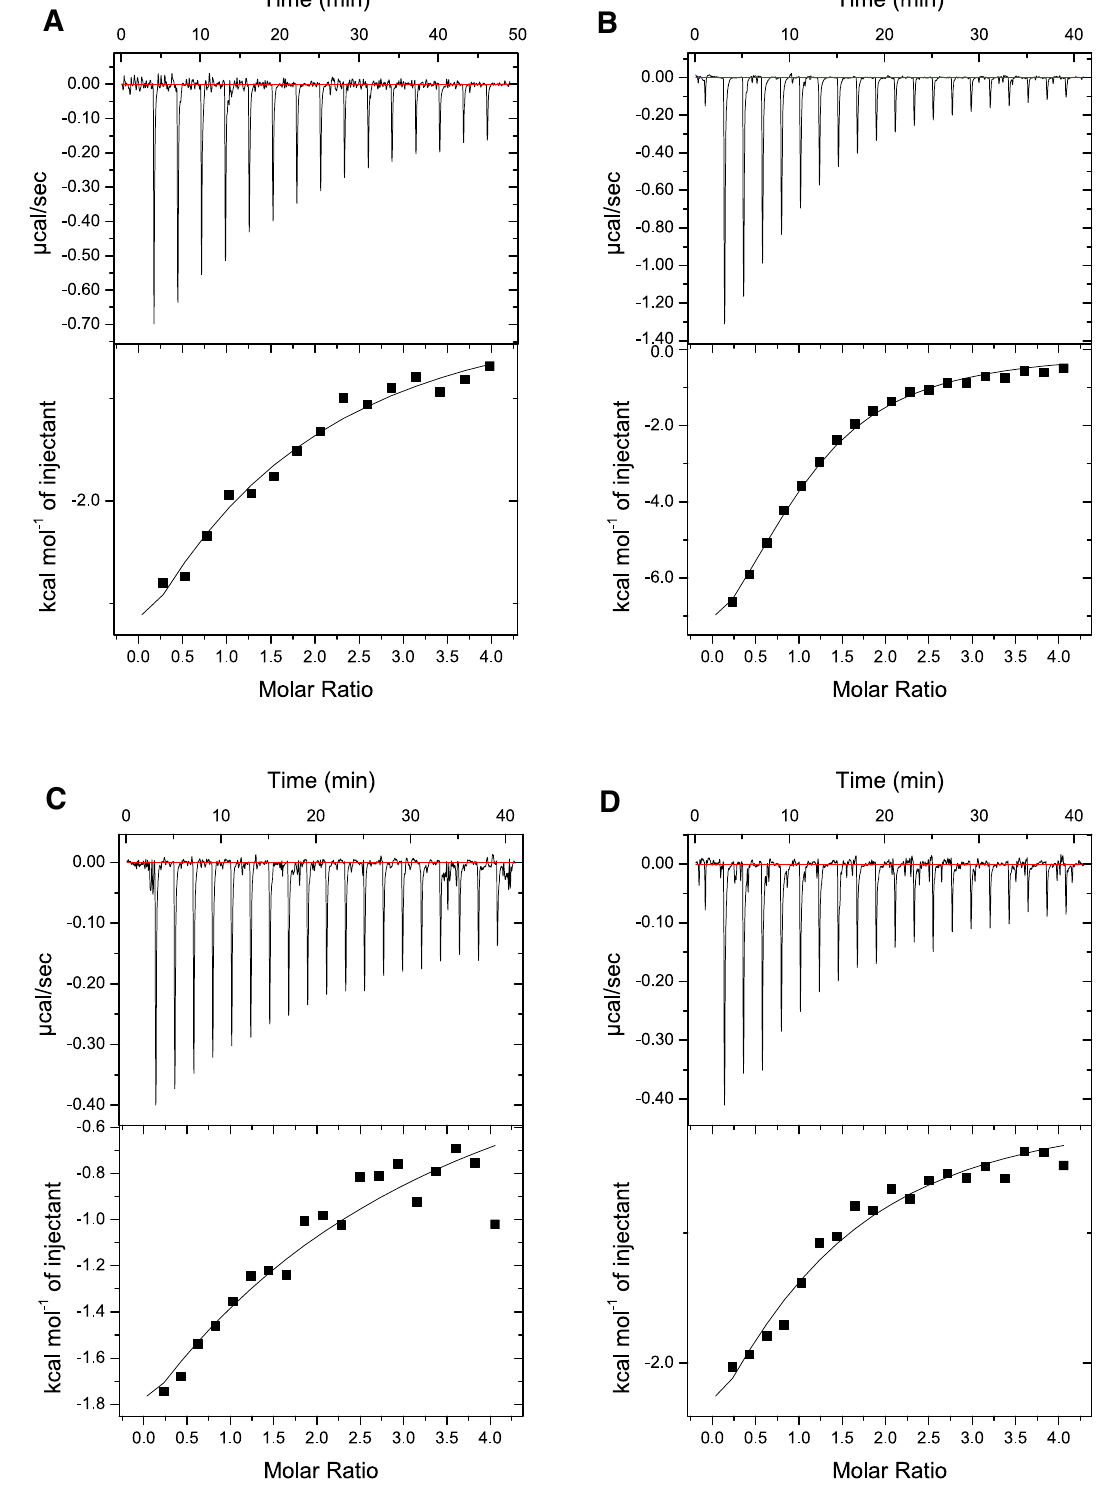
Figure 5. ( A ) A thermogram produced by injecting 1 mM asialo-GM1 saccharide into 50 µ M SeviL. The experiment was repeated three times, each thermogram being fitted to a one-site model (shown as a black line). Dissociation constants were calculated as weighted averages, and errors were calculated as weighted standard deviations, using the reciprocal chi-square values of each individual fit as weights. The K d was determined to be 0.1 mM ± 32 µ M. ( B ) A similar result to that shown in (A), but produced using 1 mM GM1b as ligand. K d = 0.1 mM ± 92 µ M. ( C ) 1 mM asialo-GM1 titrated into 50 µ M SeviL (Q12R/F126K). K d = 0.1 mM ± 36 µ M. ( D